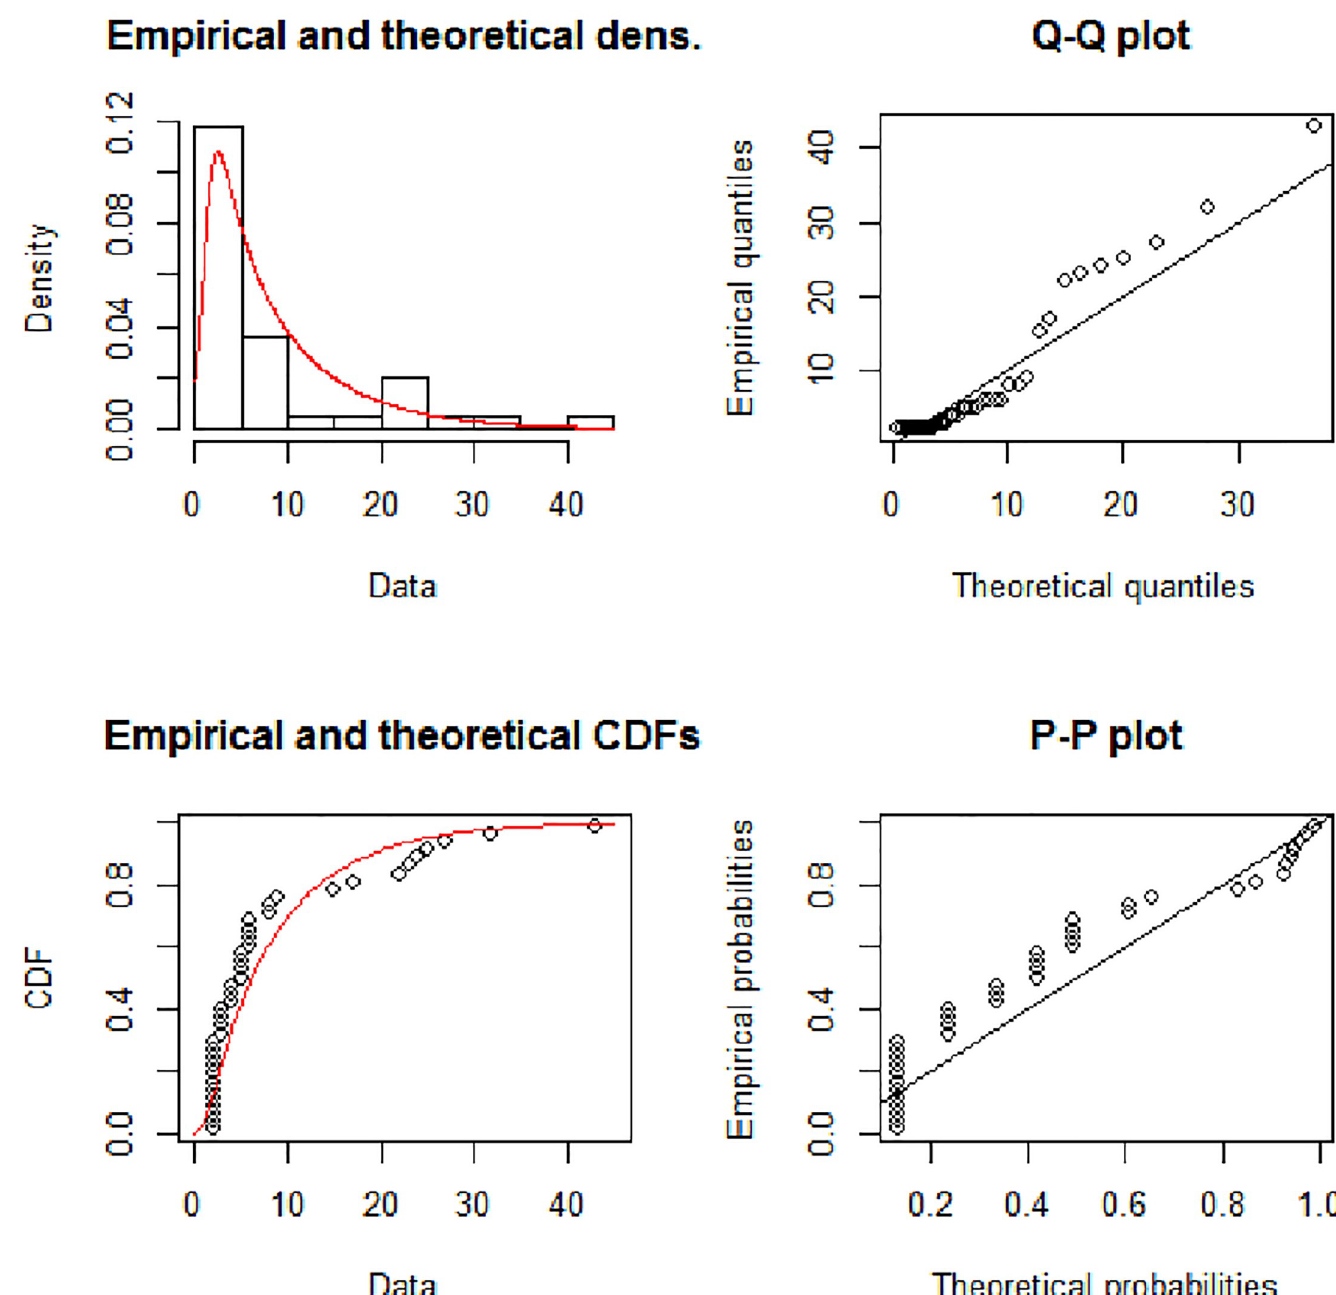
Fig 4. Theoretical and empirical Pdf and Cdf with Q-Q plot and P-P plot for LE for data set 1.